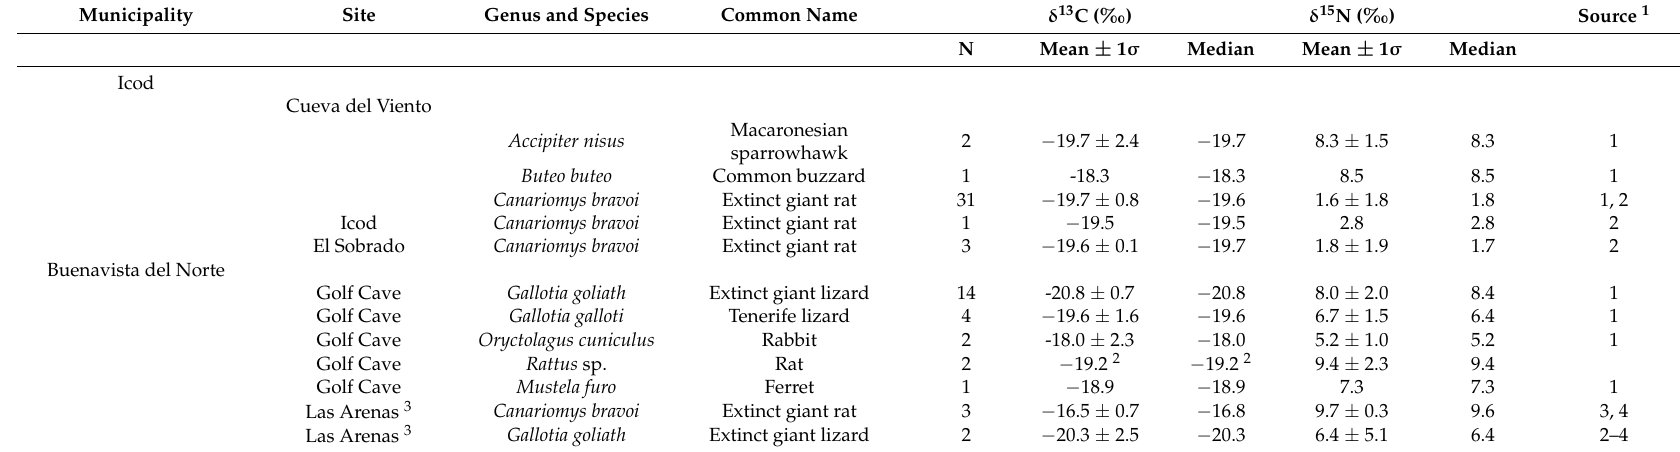
Table 1. Summary isotopic data for taxa recovered from Icod and Buenavista del Norte. Raw isotope data for all individuals are provided in Table